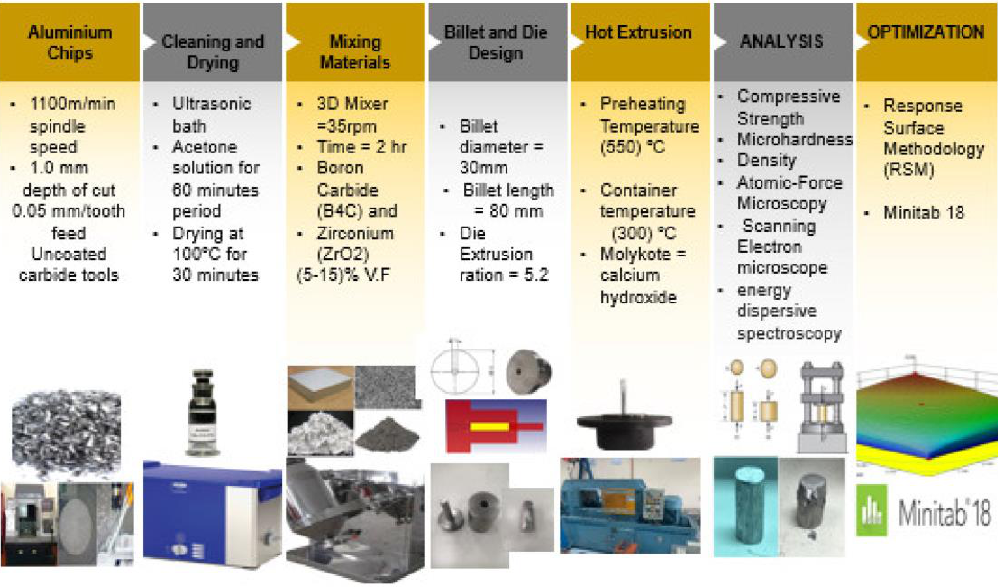
Figure 1. Experimental methods for materials preparation and characterisation.